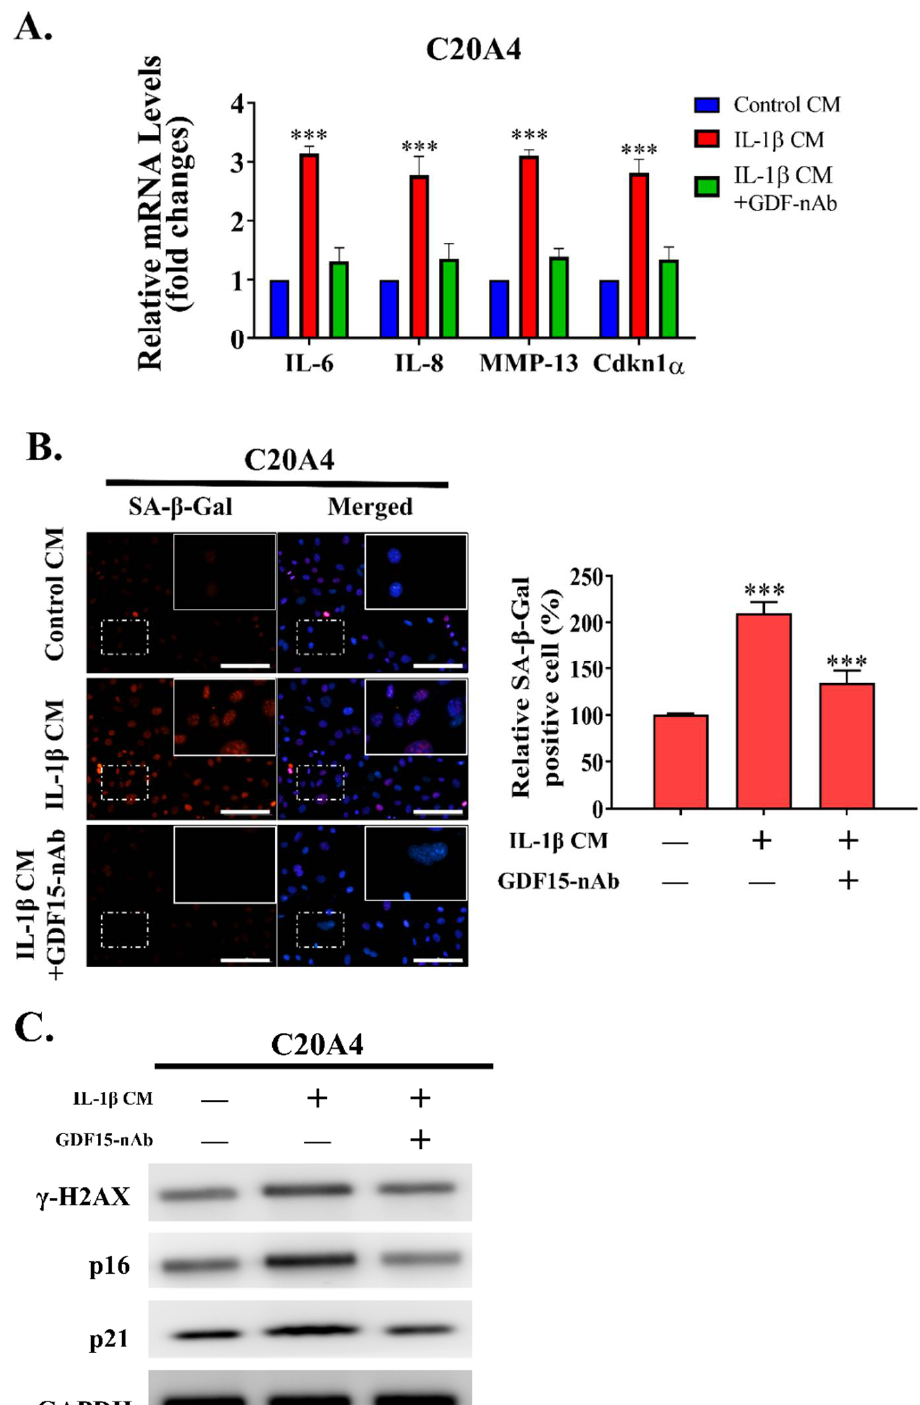
Figure 5. GDF15-nAb treatment attenuates chondrocyte senescence and SASP. ( A ) GDF15-nAb (1 µ M/24 h) inhibited the development of the SASP markers IL-6, IL-8, MMP-13, and Cdkn1a, as observed in the qRT-PCR assay. ( B ) SA- β -GAL staining in C20A4 decreased after treatment with GDF15-nAb. Scale bar: 10 µ m ( C ) Western blot assay demonstrating the effect of GDF15-nAb on chondrocytes treated with GDF15-nAb. *** p < 0.001.